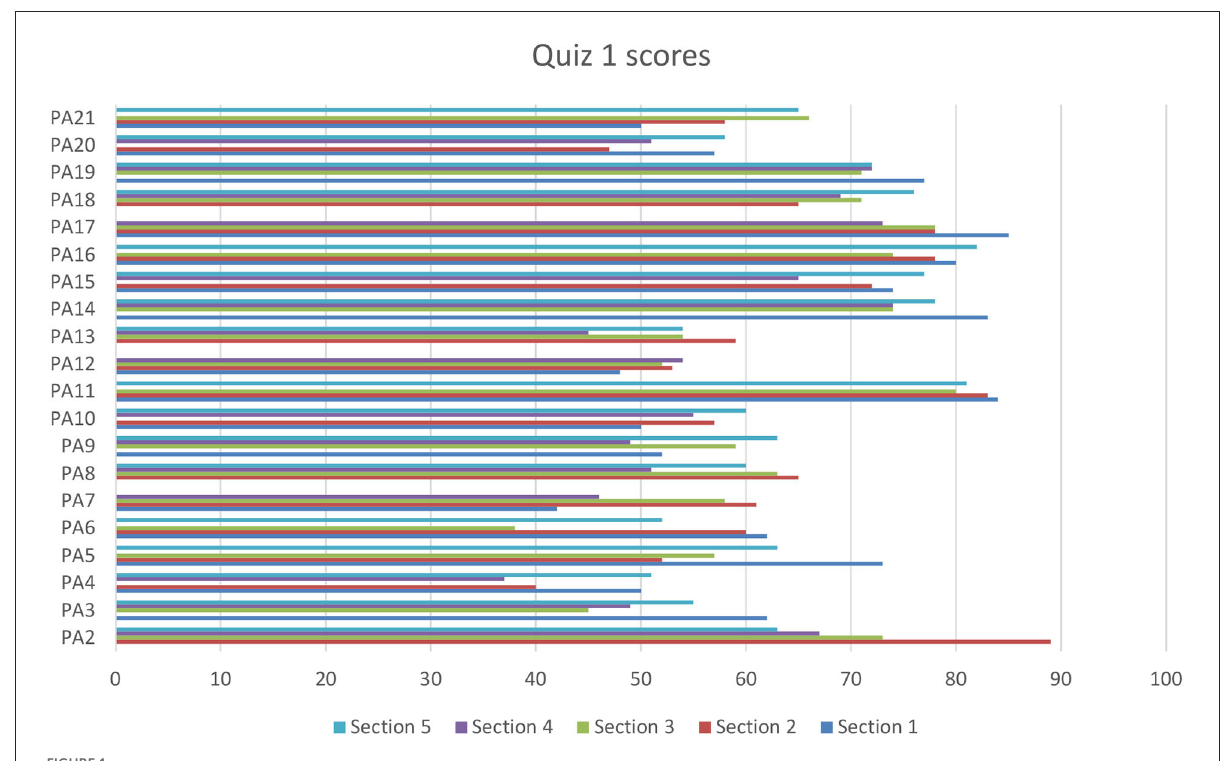
FIGURE1 Sections’ scores in QZ1 for each PA (QZ1, Quiz 1; PA, Preparatory